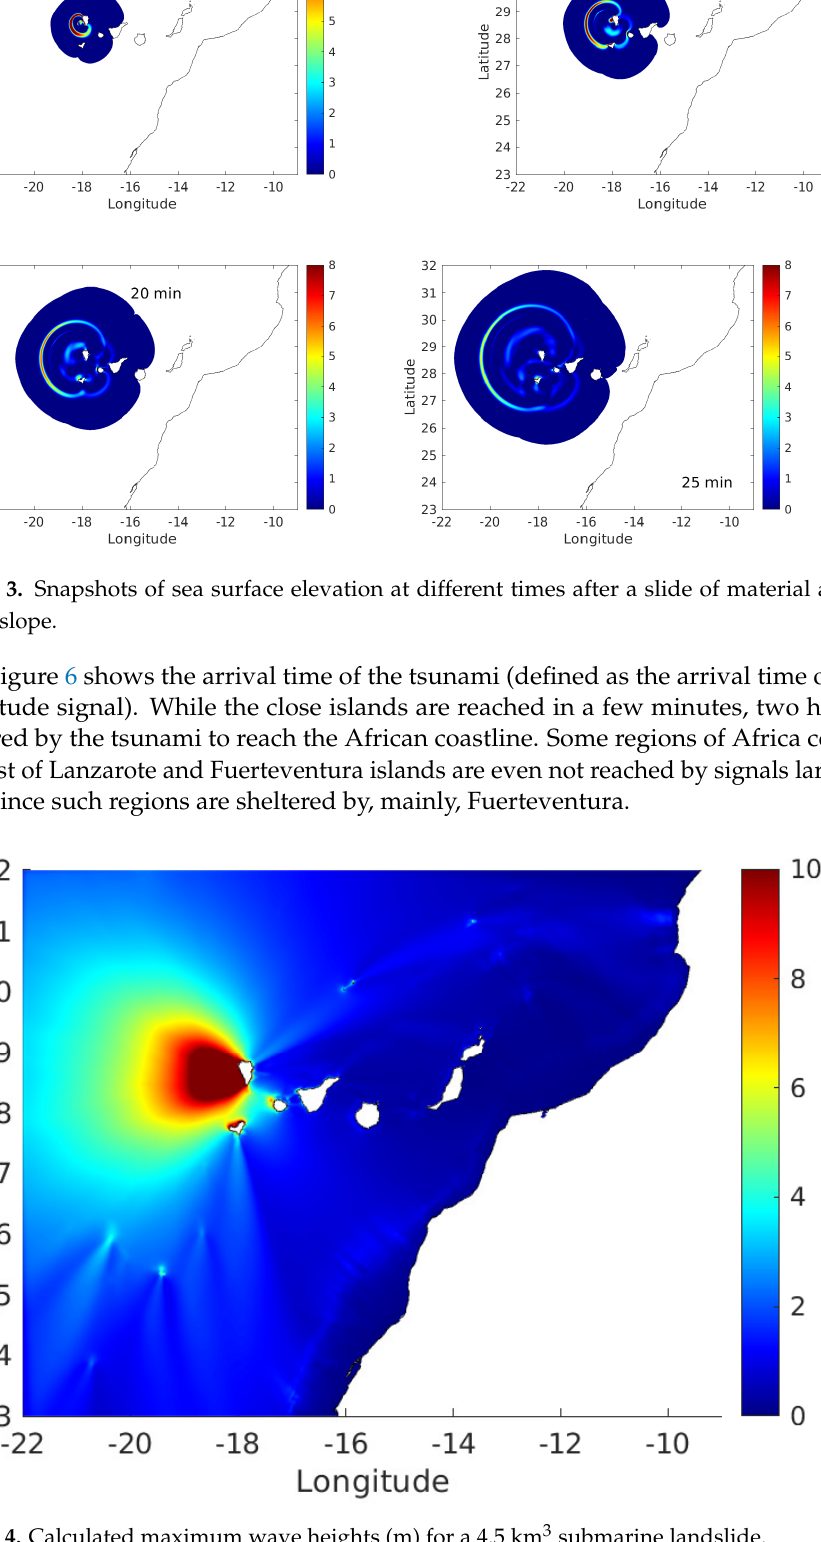
Figure 4. Calculated maximum wave heights (m) for a 4.5 km 3 submarine